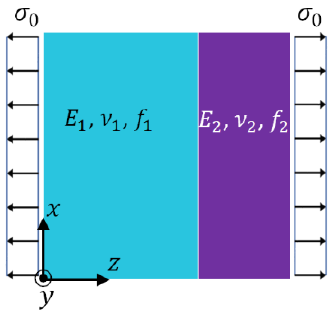
Figure A2. Iso-stress conditions.